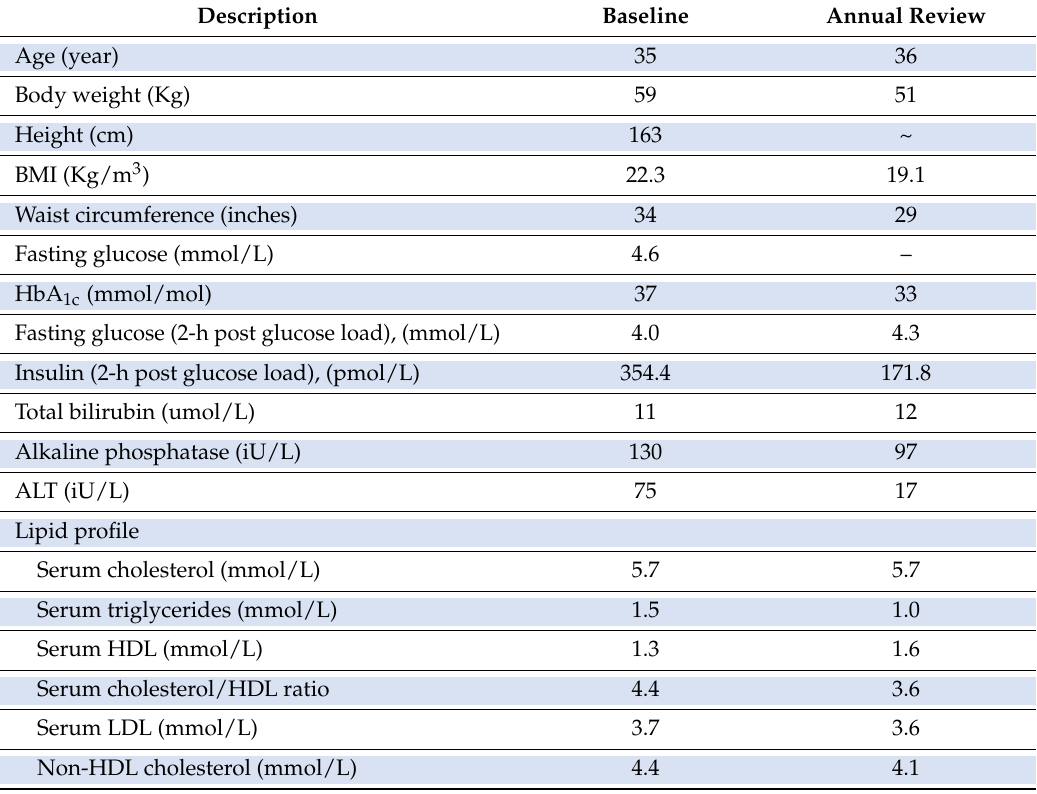
Table 1. Subject characteristics at baseline and after lifestyle